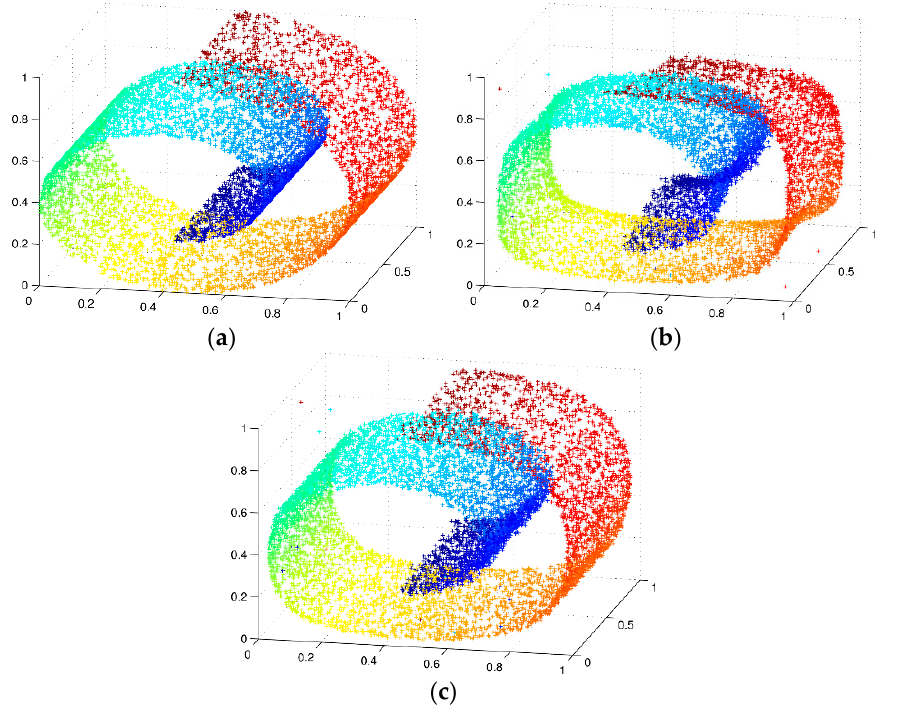
Figure 2. Reconstruction of swiss-roll dataset ( a ) Original swiss-roll dataset. The 2000 points are normalized to [0,1] ; ( b ) Autoencoder reconstruction; and ( c ) CAE reconstruction.